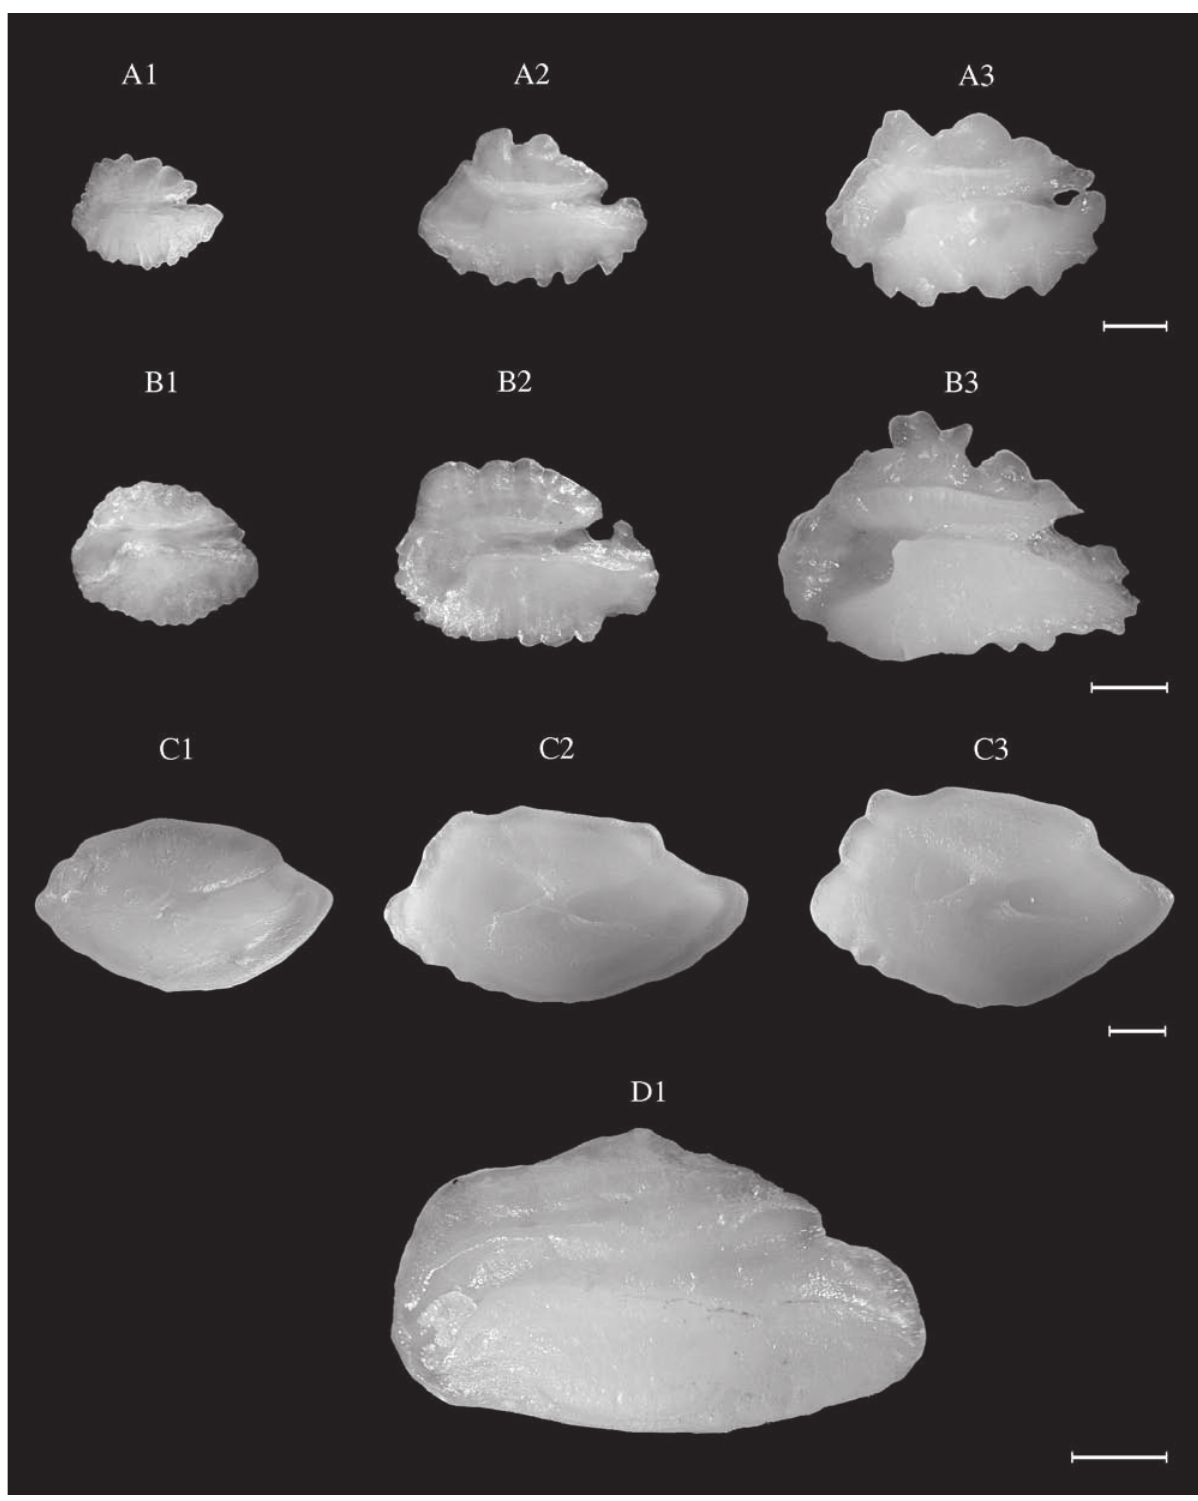
Fig. 66. – Mullus barbatus . TL: A1, 10.8 cm (WM); A2, 17.9 cm (NEA); A3, 24.5 cm (WM). Mullus surmuletus. TL: B1, 12.3 cm (WM); B2, 23.0 cm (NEA); B3, 33.0 cm (CEA). Cepola macrophthalma. TL: C1, 25.0 cm (WM); C2, 52.4 cm (NEA); C3, 84.9 cm (NEA). Abudefduf luridus (CEA). FL, D1,11.7 cm. Scale bar = 1